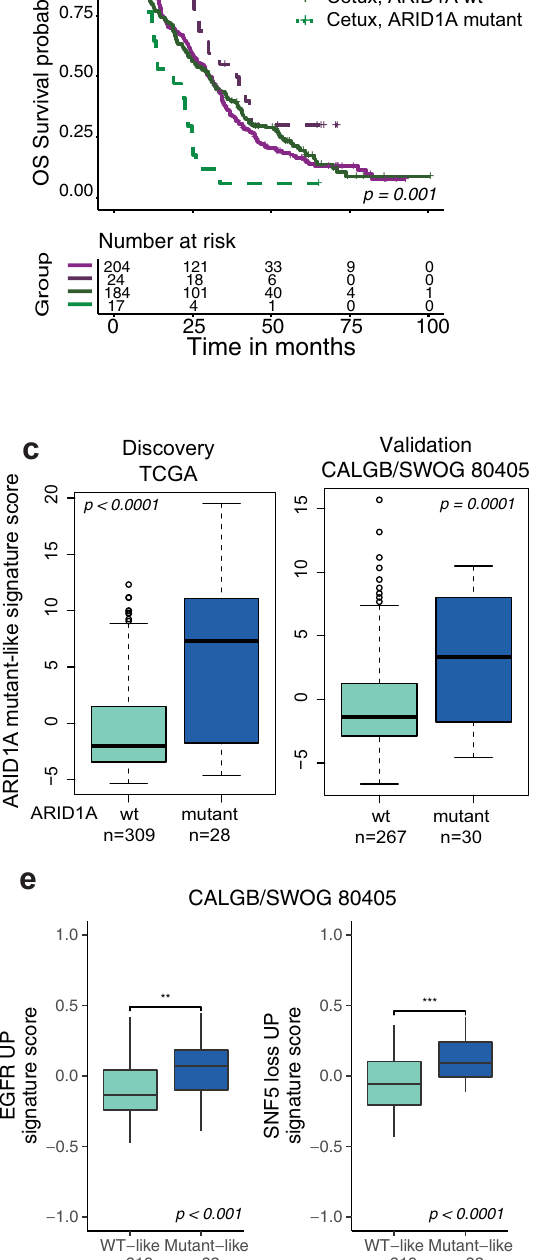
ranksumtest. d ARID1Amutant-likesignaturescoresplitintoquartileswiththe%of alterations in each quartile that were ARID1A mutant and WT in the 297 patients with both RNAseq and FMI mutation data available from the CALGB/SWOG 80405 cohort. e Distribution of MSigDB C6 Oncogenic signatures (GSVA scores) by ARID1A mutant-like signature group in CALGB/SWOG 80405. Two-sided Wilcoxon ranksumtest;* p <0.05,***, p <0.001. c , e Theinterquartilerange(IQR)isdepicted by the box with the median represented by the center line. Whiskers maximally extend to 1.5× IQR (with outliers shown). Source data are provided as a Source Data fi